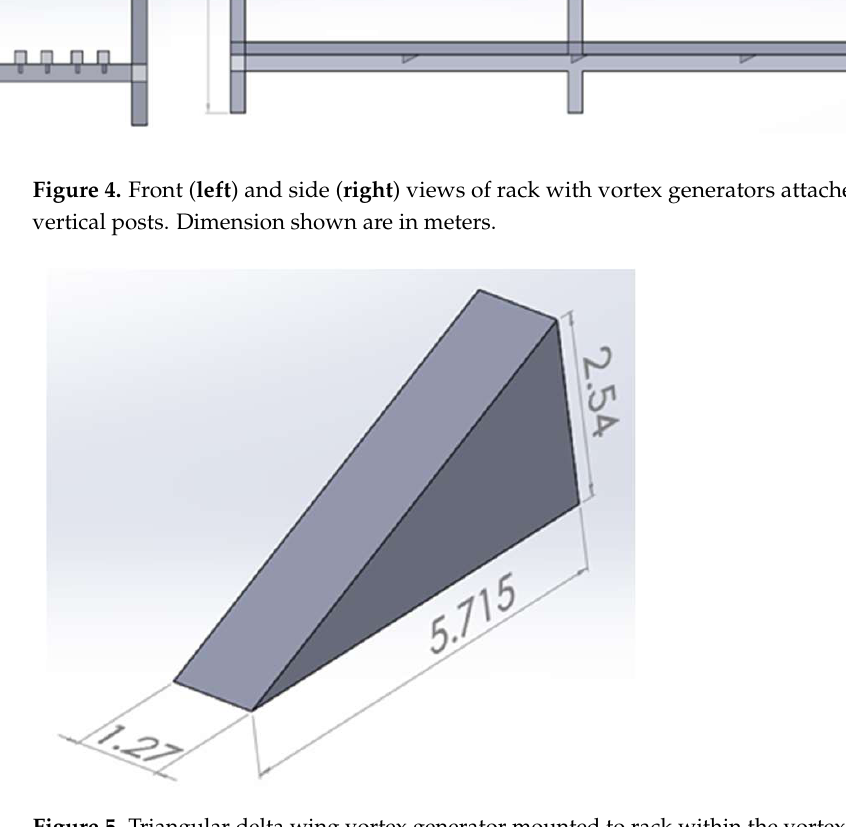
Figure 5. Triangular delta wing vortex generator mounted to rack within the vortex generator design model. Dimensions are in centimeters.